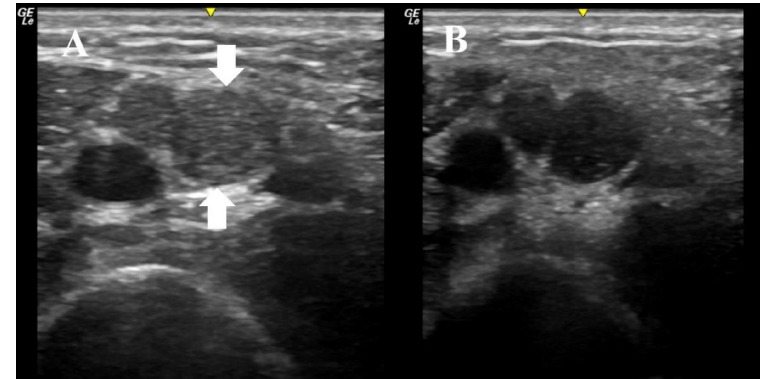
Figure 1. These ultrasound images were obtained with a 22 MHz linear array transducer, and they depict the median nerve in the right arm of an 11-year-old boy with subacute distal weakness and sensory loss; ( A ) demonstrates imaging with the transducer at 90 degrees to the nerve. The nerve has two large fascicles, one between the arrows and the other directly to the left of the largest fascicle. The area of the nerve at this site is 20 mm 2 . ( B ) demonstrates the same image, but the transducer is at an angle just slightly off 90 degrees, which demonstrates the anisotropy of the nerve at this site, as the fascicles become hypoechoic with just a minor alteration of the angle of insonation. This boy was treated with IVIG and his strength normalized.